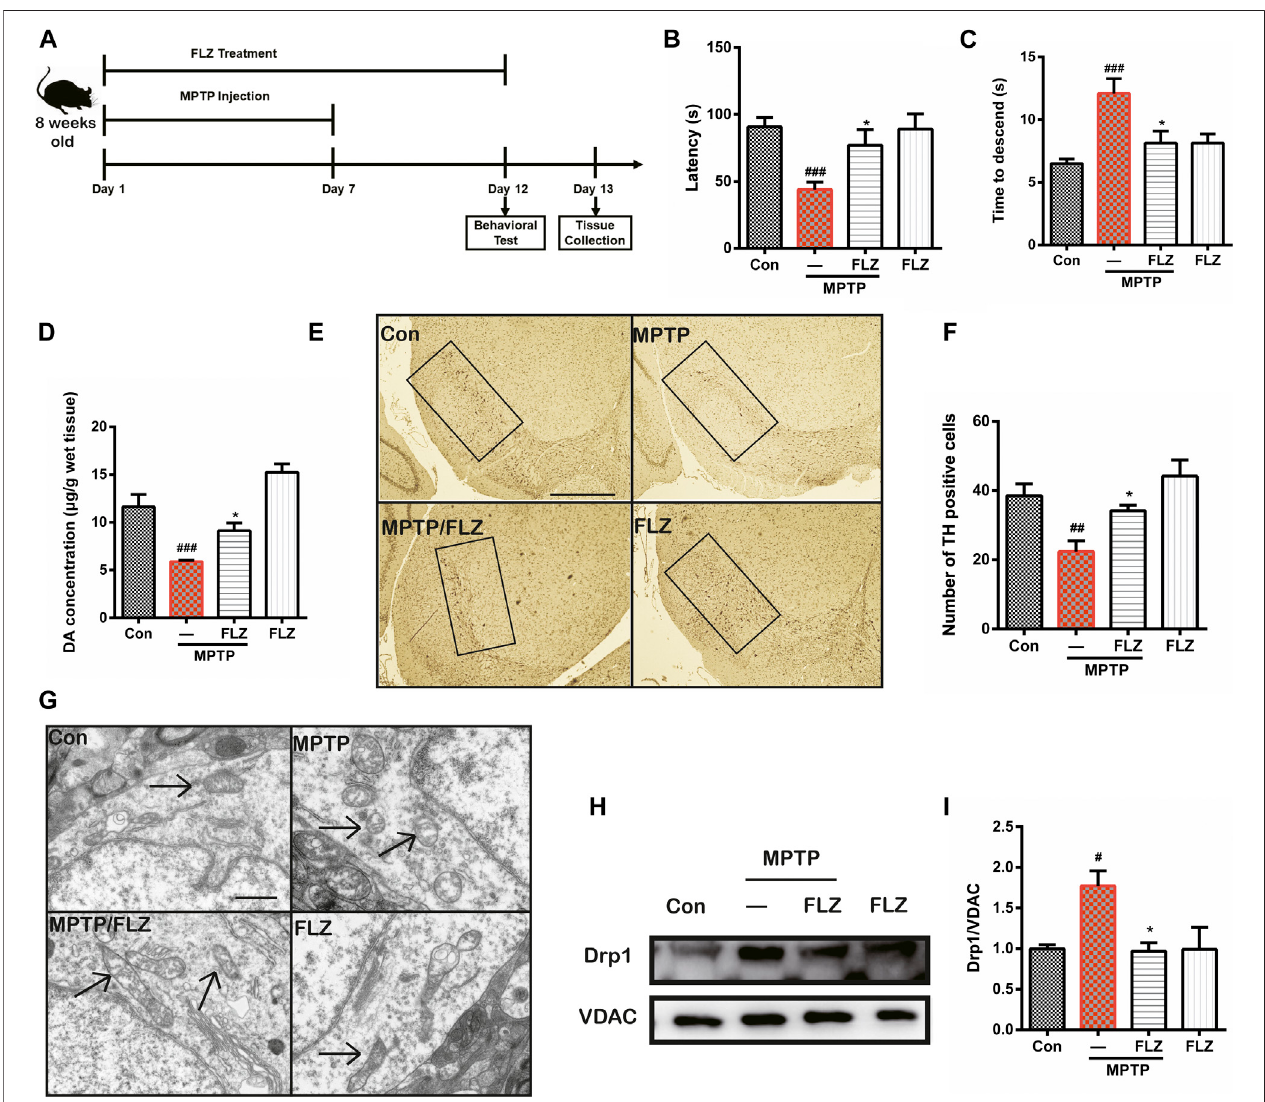
FIGURE7| FLZtreatmentreducedmotordysfunction and mitochondrialfragmentation inMPTP-treated mice (A) the experimental arrangement.Measurementof micemotorperformanceusingthe (B) rotarod test and (C) poletest (D) DAconcentrationwasmeasured byHPLC.One-wayANOVA followed byBonferroni ’ spost hoc comparisons tests were performed in statistical analyses. (E, F) The number of TH-positive neurons in SNpc was counted and provided in a histogram (G) The morphology of mitochondria was measured by electron microscope. (H, I) Western blot analysis of mitochondrial fractions of tissue was determined by Drp1 and VDACantibodies.VDACwasusedasaloadingcontrol.One-wayANOVAfollowedbyTukeyposthoccomparisonstestswereperformedinallstatisticalanalyses. ### p < 0.001, ## p < 0.01 and # p < 0.05 vs. Control group, * p < 0.05 vs. MPP + treated